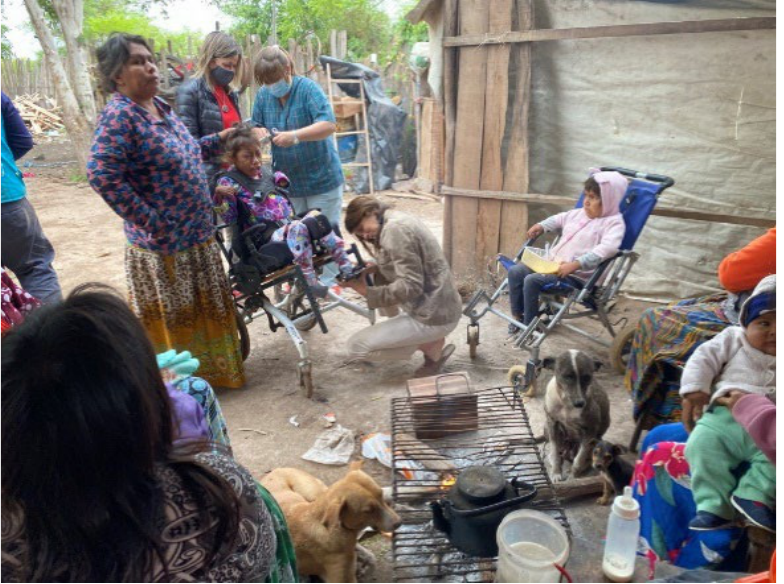
Figure 4. Asistiva clinics: community-based rehabilitation principles at work.